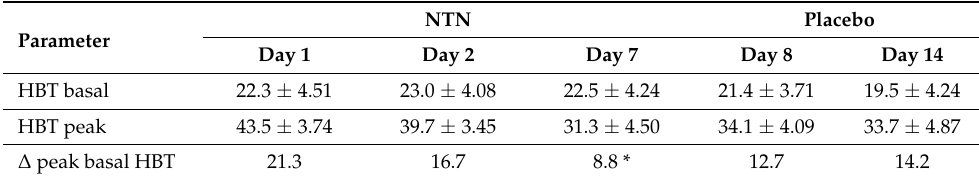
Table 2. Evolution of the hydrogen breath test in patients receiving NTN on Days 1–7 with crossover to placebo on Days 8–14.